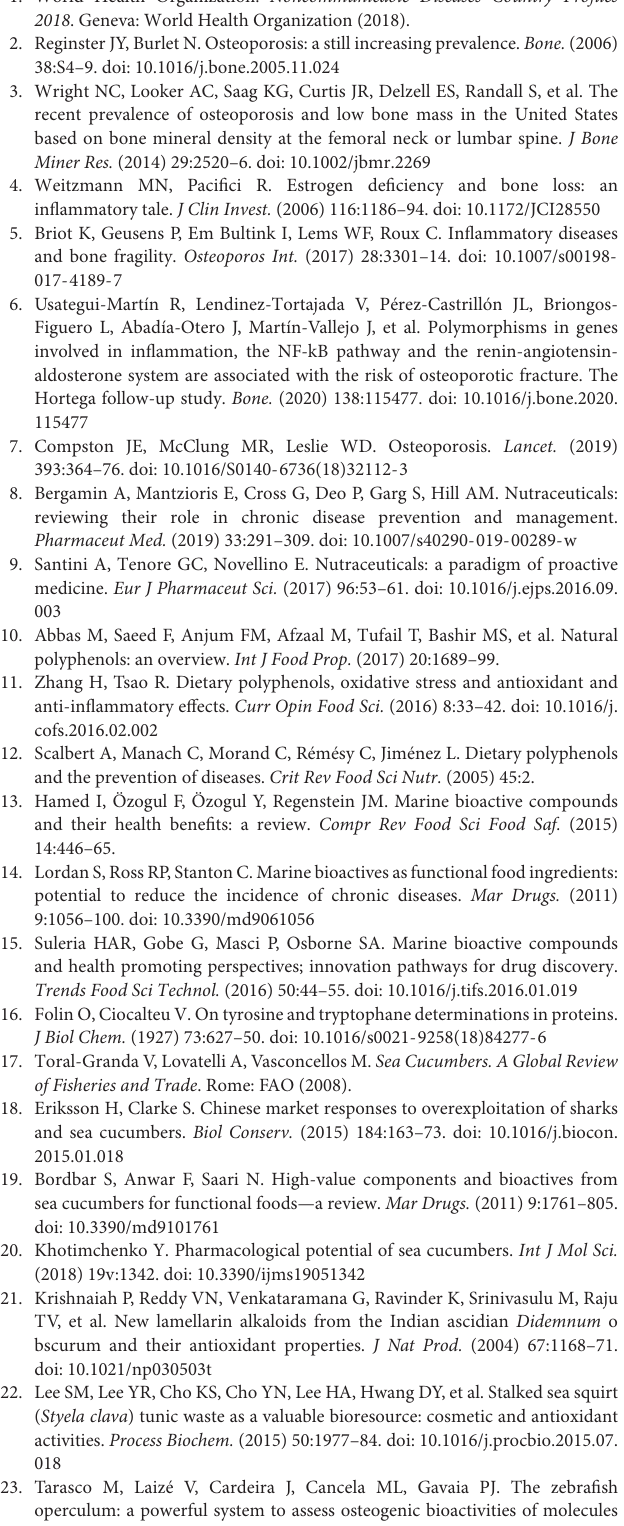
Figuero L, Abadía-Otero J, Martín-Vallejo J, et al. Polymorphisms in genes involved in inflammation, the NF-kB pathway and the renin-angiotensin- aldosterone system are associated with the risk of osteoporotic fracture. The Hortega follow-up study. Bone. (2020) 138:115477. doi: